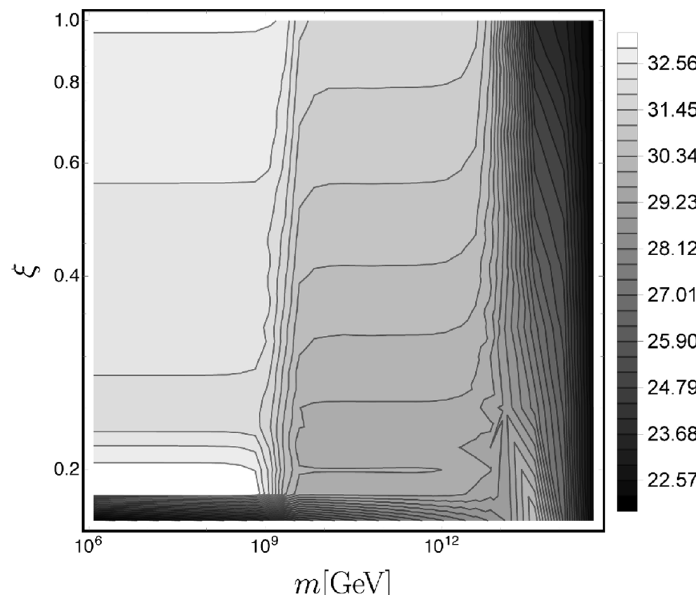
Figure 6 . In this (cid:12)gure we are showing the particle density in logarithmic scale at the end of reheating, i.e., the contours of log n ( t rh ) as a function of the mass m and the coupling to 10 curvature (cid:24) . We can see clearly the di(cid:11)erent behaviors of the production. For the lightest masses, the enhancement mechanism is the tachyonic instability. There is a transition regime for masses of about 10 9 GeV in which there are contributions from the tachyonic instability and the resonant e(cid:11)ect. For masses lower than the energy scale of in(cid:13)ation the only enhancement mechanism is the resonance between the frequency of the (cid:12)eld and the one of the Ricci scalar. For masses above the energy scale of in(cid:13)ation, there are no enhancement mechanisms and the typical production from a de Sitter phase is